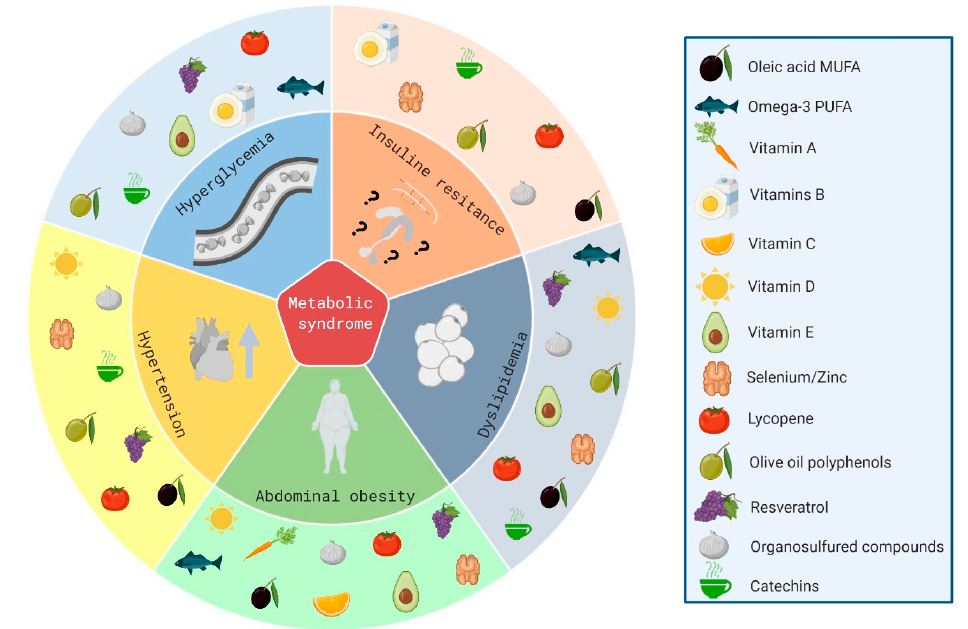
Figure 4. Main nutrient impact on metabolic syndrome (MetS) components. The MetS is a constellation of pathologic conditions which includes hyperglycemia, insulin resistance, dyslipidemia (hypertriglyceridemia and low high density lipoprotein (HDL)-cholesterol levels), central obesity, and hypertension. Several studies have demonstrated that nutrients such as oleic acid monounsaturated fatty acid (MUFA), omega-3 polyunsaturated fatty acids (PUFAs), vitamins A, B, C, D, and E, selenium and zinc elements, lycopene, olive oil polyphenols, resveratrol, organosulfured compounds, and catechins have a positive impact on MEtS components, improving the onset and development of the